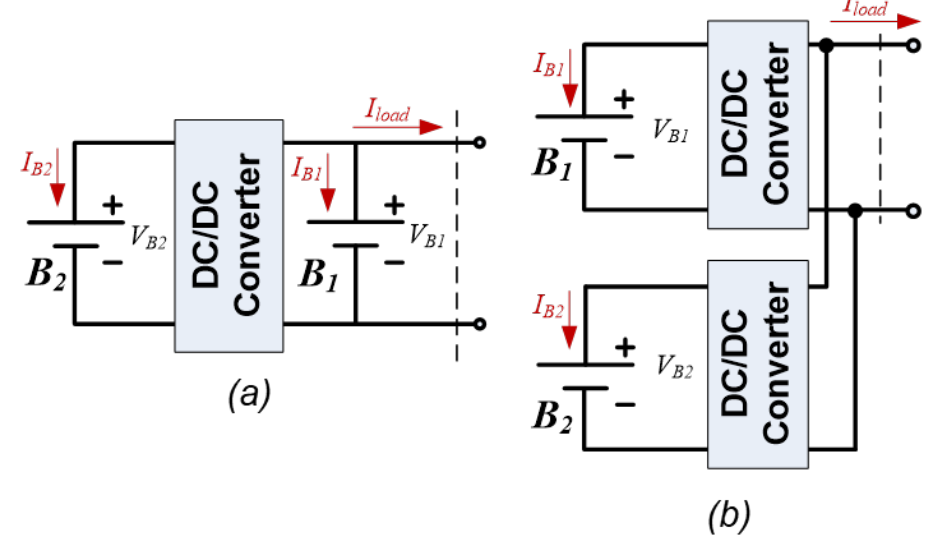
Figure 5. Cascaded architecture ( a ). Common DC bus architecture ( b ).